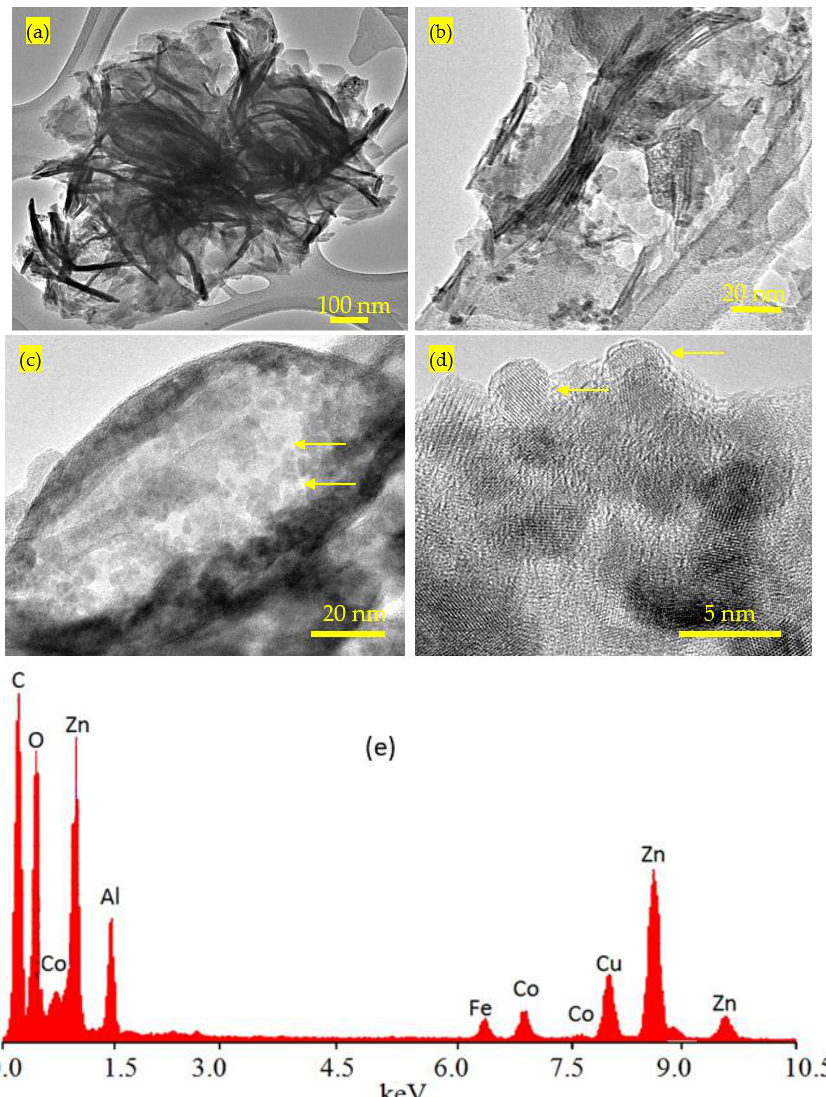
Figure 4. TEM images of the nanohybrid NHZ-1: ( a ) at 100 nm, ( b , c ) at 20 nm, ( d ) at 5 nm (yellow arrows for the intercalated nanoparticles) and, ( e ) EDX spectrum.